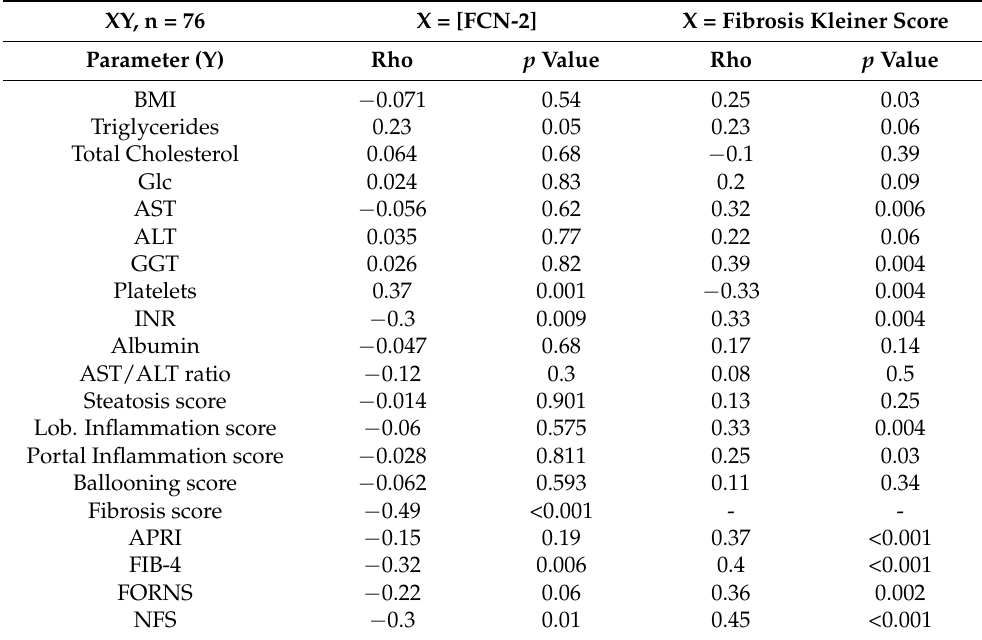
Table 4. Correlations between the blood parameters and fibrosis in the discovery cohort. XY, n = 76.